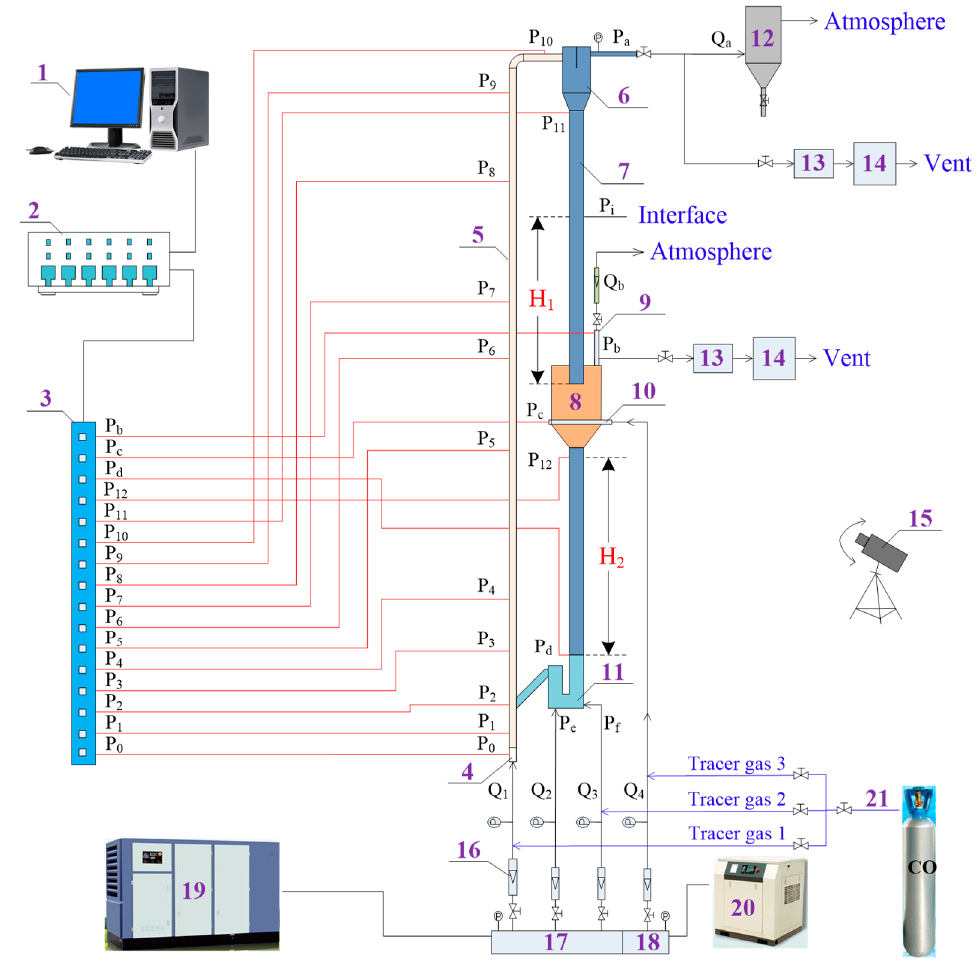
Figure 2. Schematic of the visualization experimental device of the iG-CLC system. 1–computer, 2–A/D